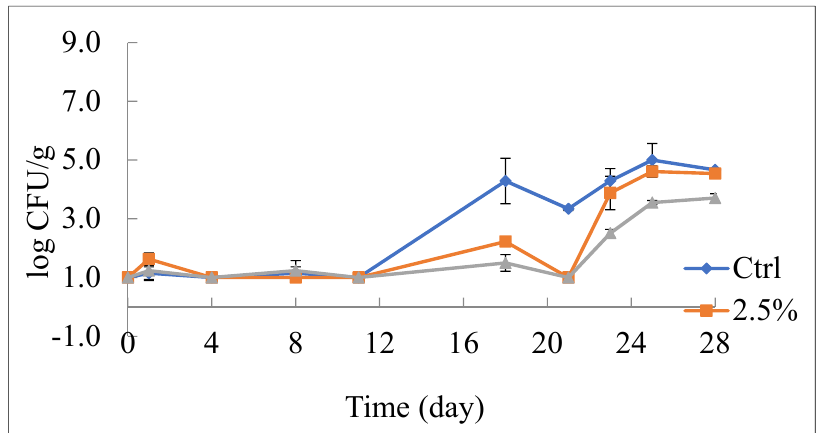
Figure 3. Evolution of lactic acid bacteria in fruit salad during 28 days of refrigerated storage (5 °C). Ctrl: fruit salad without pomegranate peel powder; 2.5%: fruit salad with 2.5% ( w / v ) pomegranate peel powder; 5%: fruit salad with 5% ( w / v ) pomegranate peel powder.